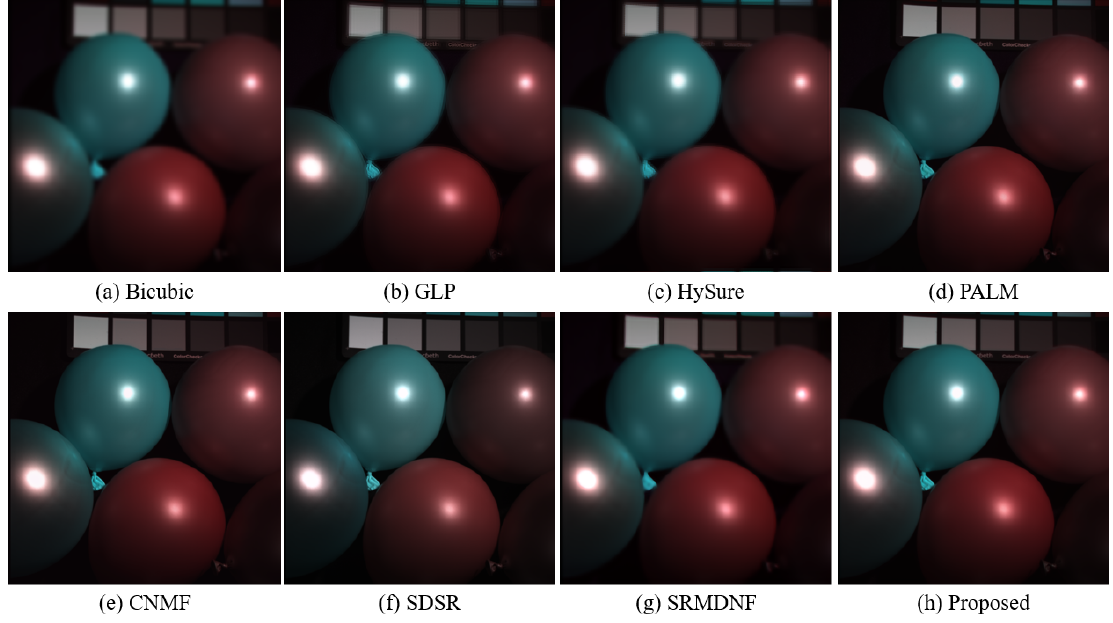
Figure 6. Super-resolution reconstruction results on the Balloons image from the CAVE dataset with a magnification factor of three. ( a ) Bicubic; ( b ) GLP; ( c ) HySure; ( d ) PALM; ( e ) CNMF; ( f ) SDSR; ( g ) SRMDNF; ( h )